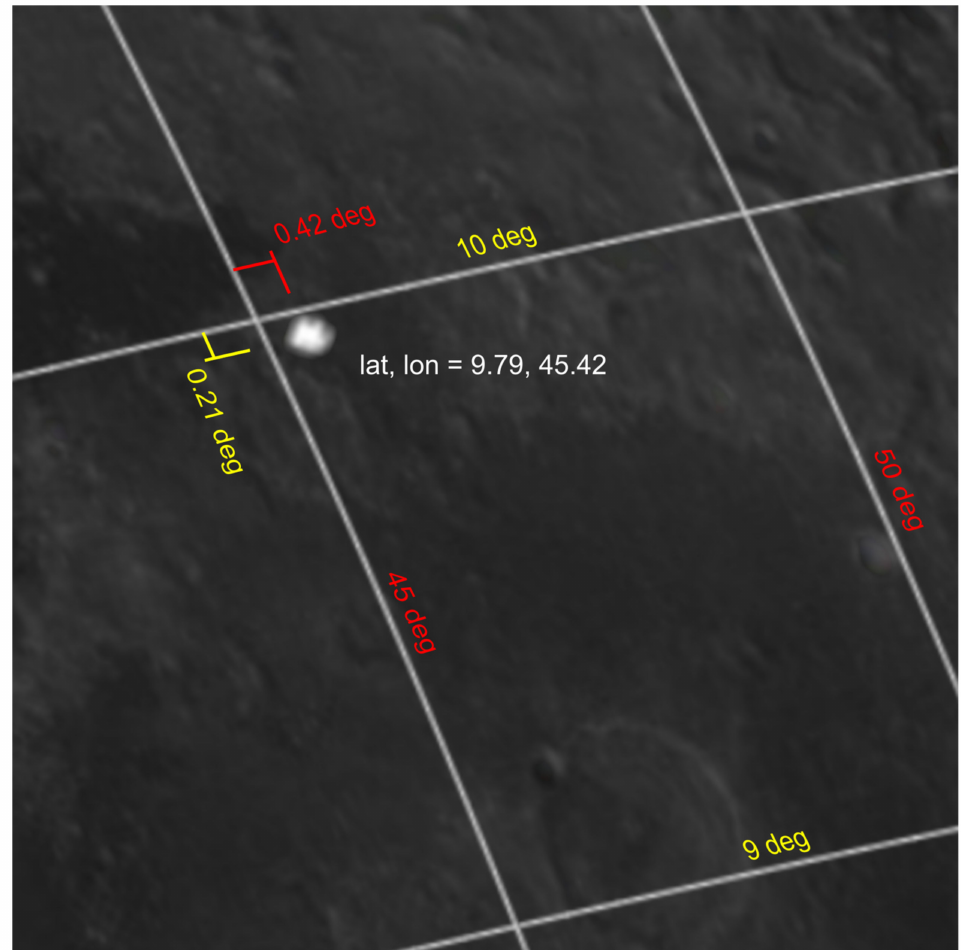
Figure 8. The location of the barycentre of Flash 1 in selenographic